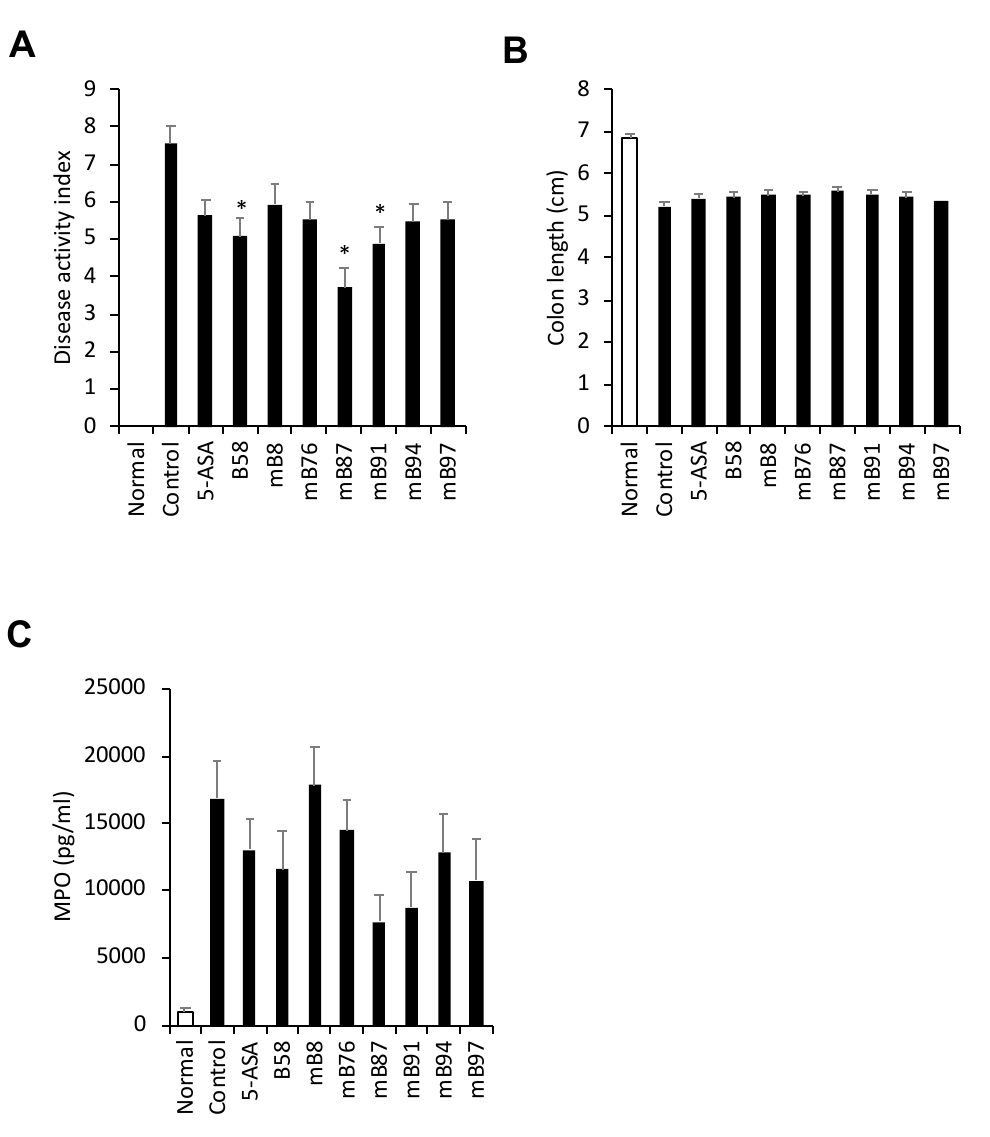
Figure 2. Effect of seven selected samples on DSS-induced colitis in mice. Colitis was induced in C57BL/6 mice by the administration of 1.7% DSS in the drinking water for 7 days. The animals were orally administered the extract samples (200 mg/kg) or 5-ASA (200 mg/kg), the reference drug, once per day. The disease activity index was scored during the experiment ( A ). Colon length was measured at necropsy ( B ). MPO in the colon lysate was measured by using an ELISA kit ( C ). The data are presented as the mean ± SEM. n = 6–8, * p < 0.05 vs.